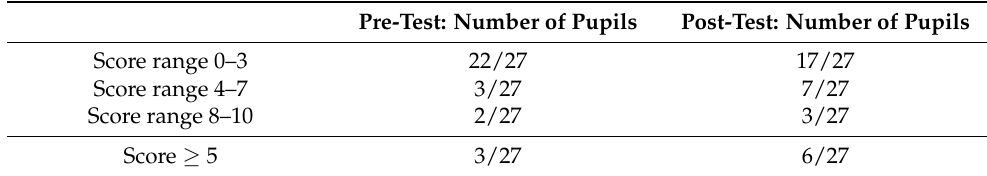
Table 9. Descriptive analysis for the contextual cues